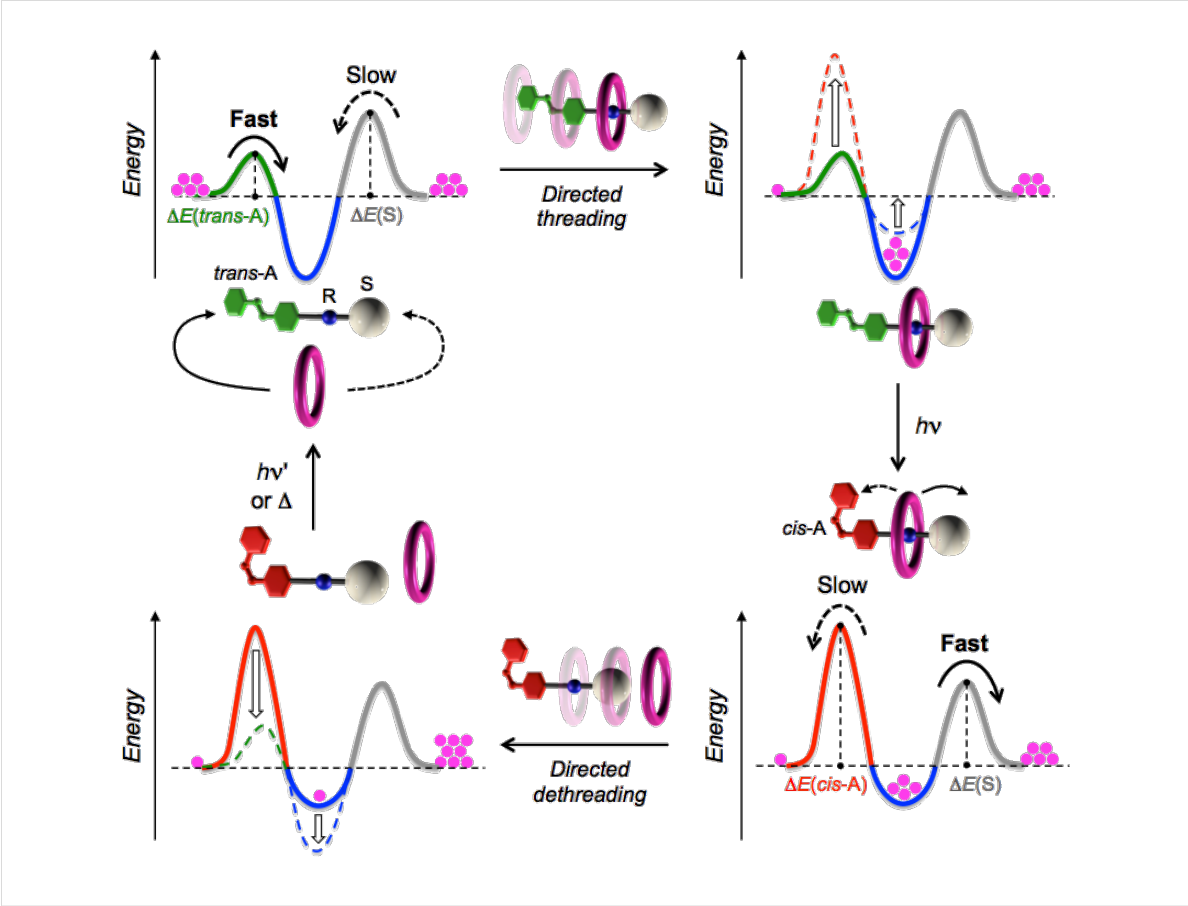
Figure 3: A minimalistic strategy for the photoinduced transit of a macrocycle along a nonsymmetric molecular axle. A simplified representation of the potential energy profile as a function of the ring–axle distance is shown for each state of the cycle. The periodic modulation of the potential energy maxima and minima, induced by light, enables the directionally controlled threading and dethreading of the molecular components.